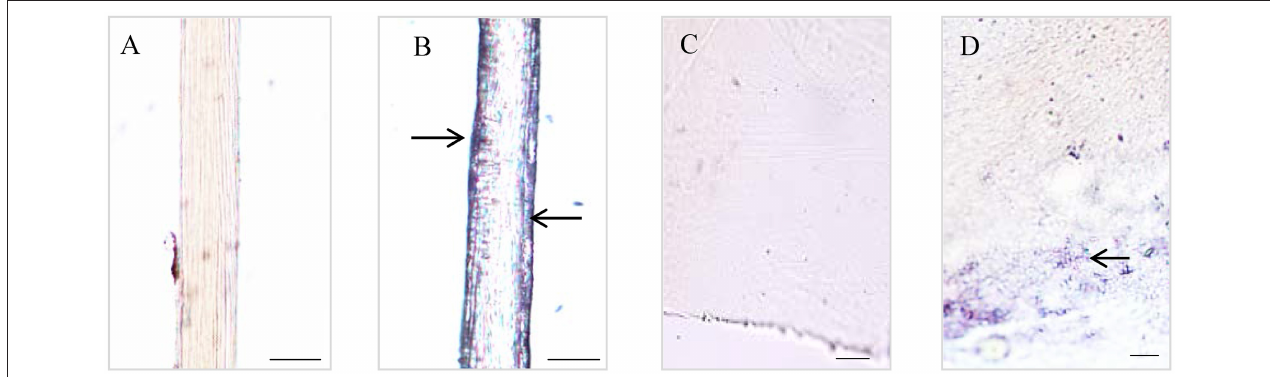
FIGURE 2 | Histological staining observations on different parts of Limnoperna fortunei byssus. Light micrographs of byssal thread longitudinal section before (A) and after (B) nitroblue tetrazolium (NBT)/Glycinate staining. Light micrographs of adhesive plaque transverse section before (C) and after (D) NBT/Glycinate staining. The arrows indicate the distribution regions of Dopa-containing proteins stained by NBT/Glycinate. Bar scale is 20 µ m in (A , B) , and 10 µ m in (C,D)